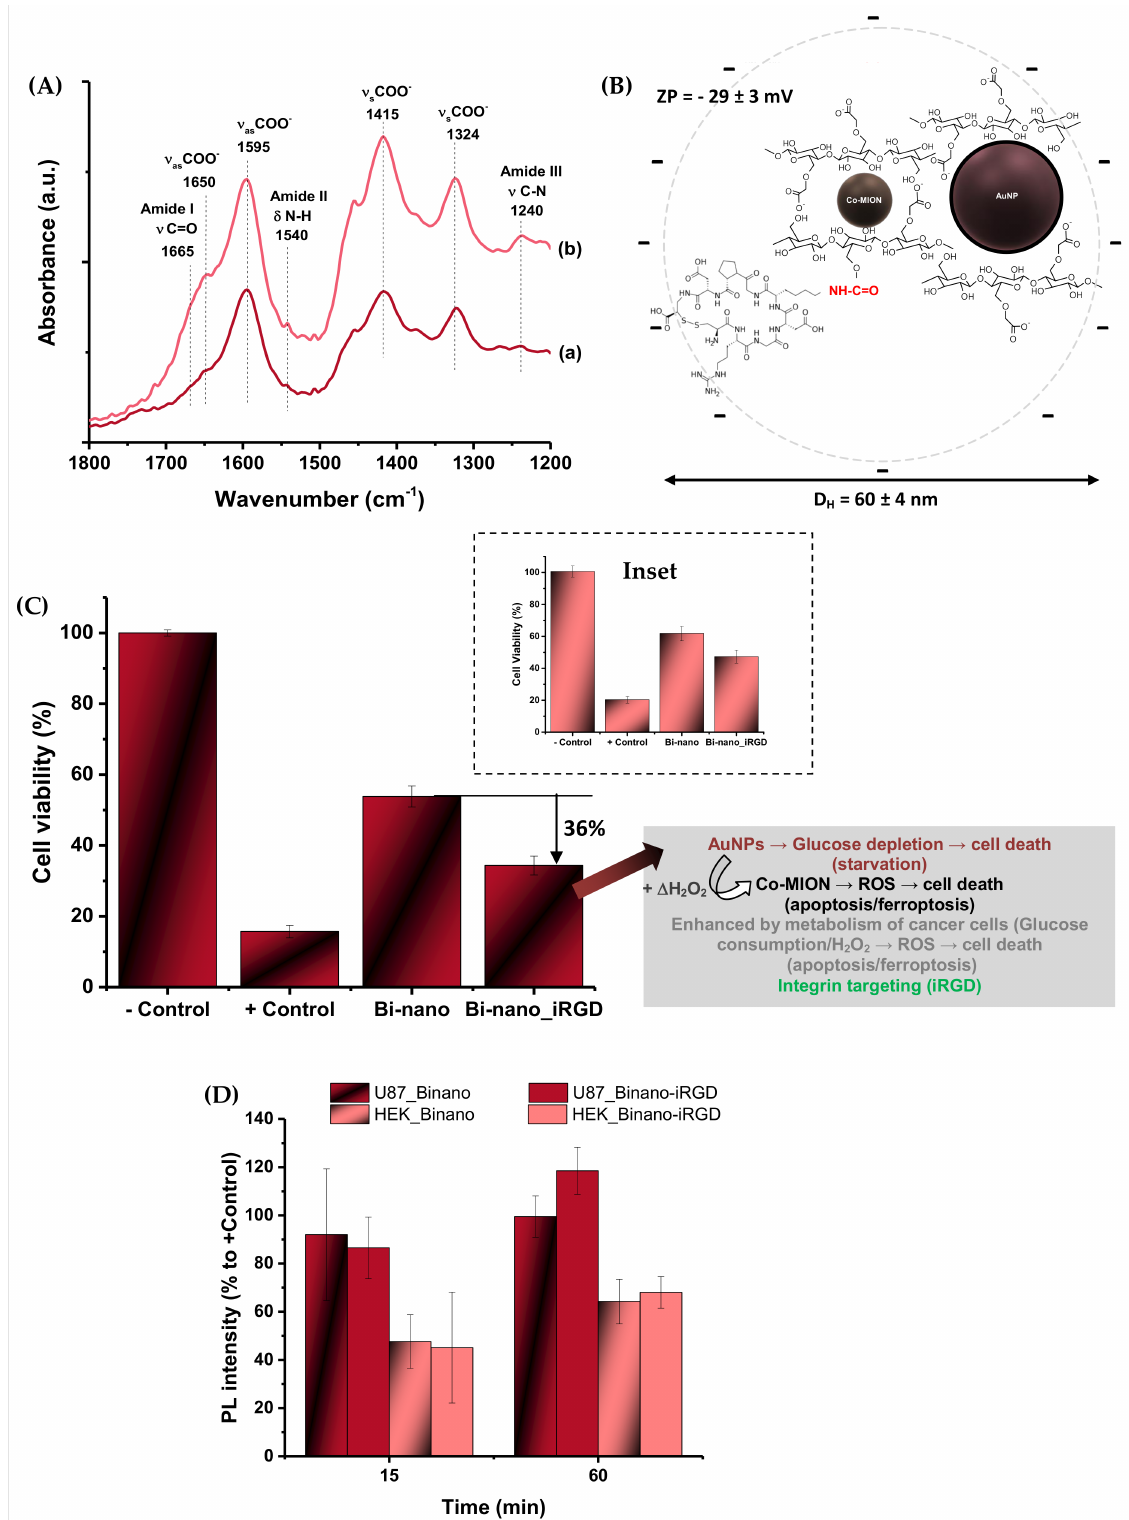
Figure 9. ( A ) FTIR spectra and ( B ) ZP and H D values of Bi-nano upon conjugation with iRGD peptides. ( C ) MTT results of the effects of targeting of the nanostructure by iRGD peptides in contact with the U87 cancer cell line and HEK 293T normal cell line (inset). ( D ) Effects of iRGD conjugation on the intracellular ROS generated by normal and cancer cells after 15 and 60 min of incubation (binanozyme concentration in the MTT and ROS experiments: 3.5 µ g/mL//15 µ g/mL,